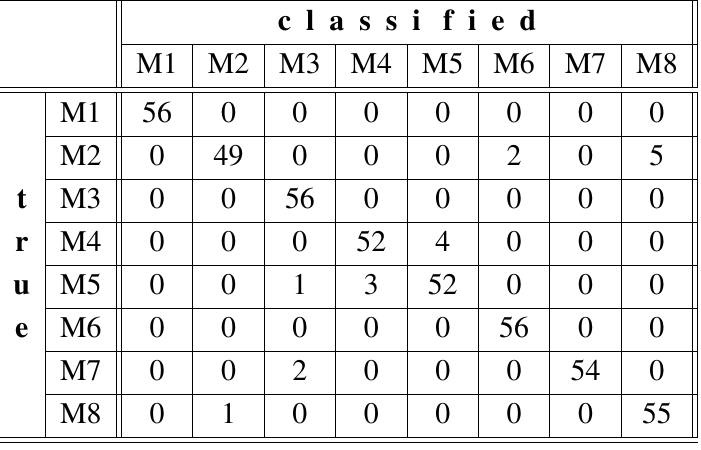
Table 11. Confusion matrix for DTW-2 (LOO cross validation,